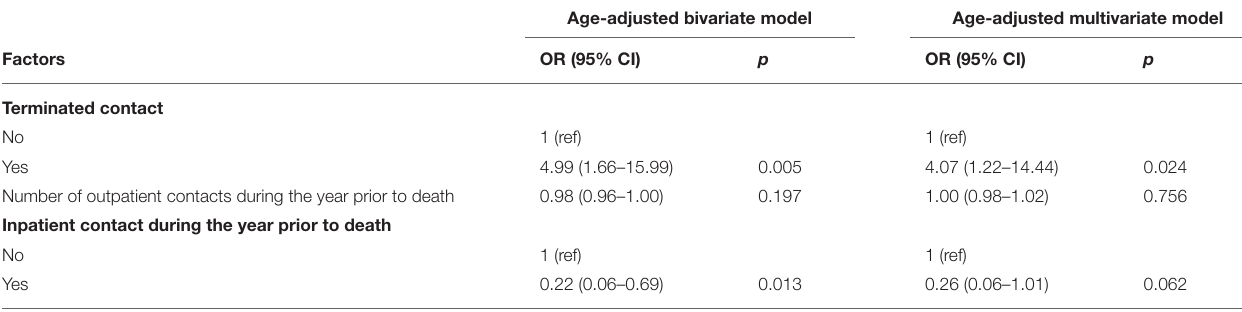
TABLE 3 | Differences in characteristics and service utilization between girls (reference) and